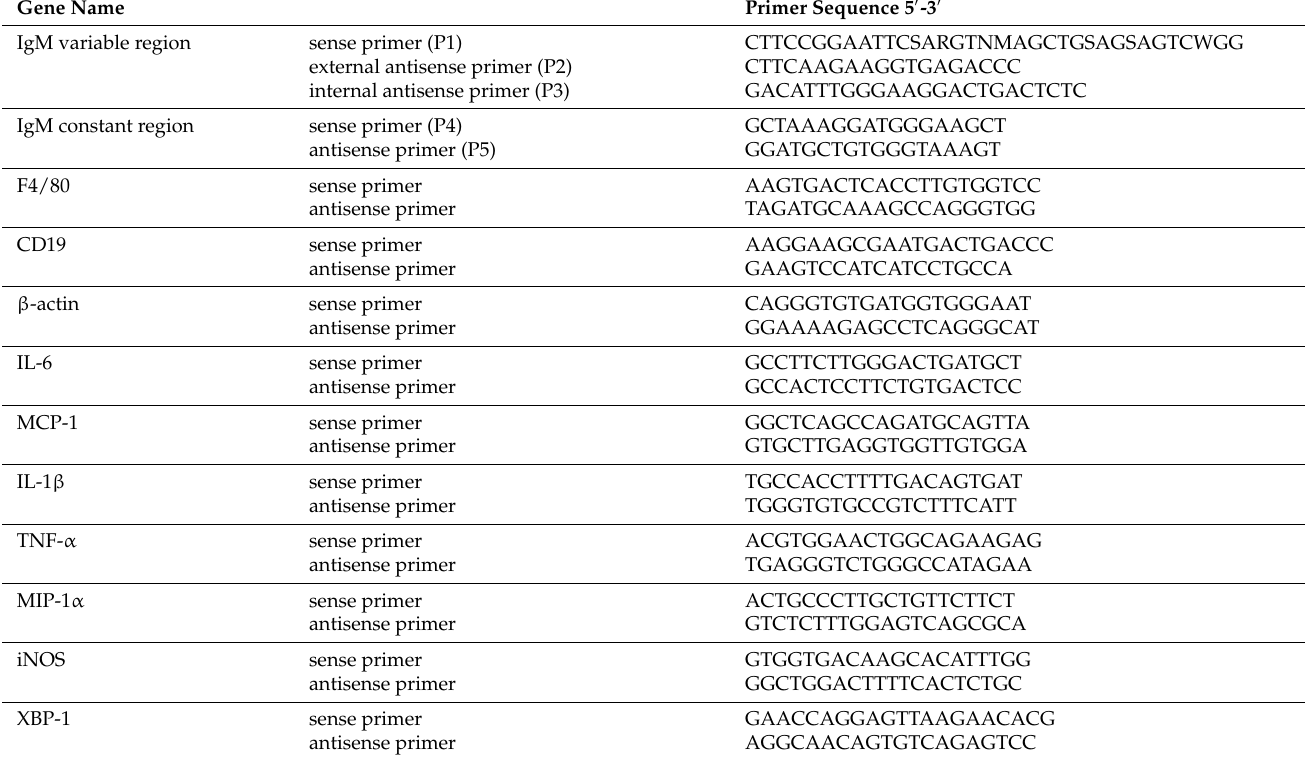
Table 1. The sequences of PCR primers were used in this